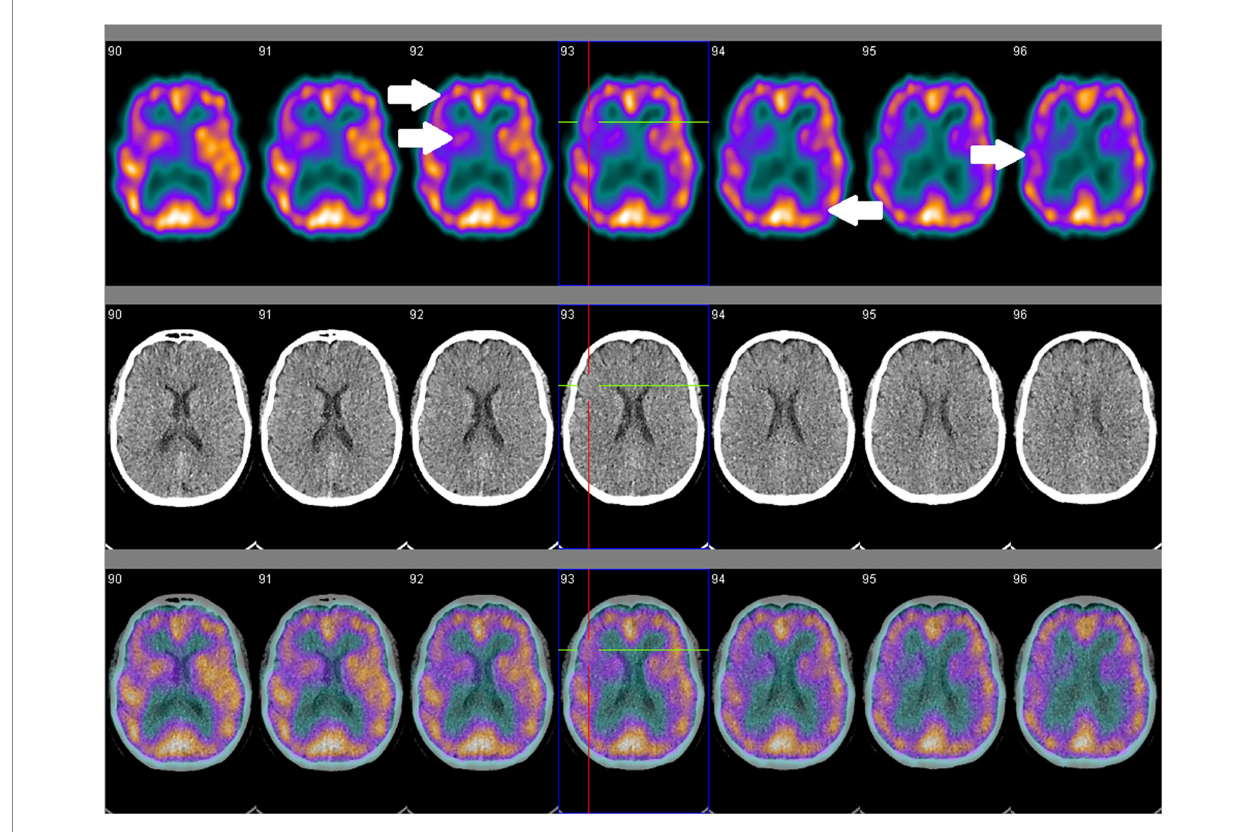
FIGURE 2 SPECT coregistered to CT (SPECT/CT) in a 56-year old female with clinically and serologically inactive SLE and no overt neuropsychiatric symptoms showing asymmetrical perfusion. Comparison between right and left sides are necessary for qualitative assessment. Focal areas of hypoperfusion (arrows) are seen in the frontal, temporal and occipital lobes, and the caudate, putamen and